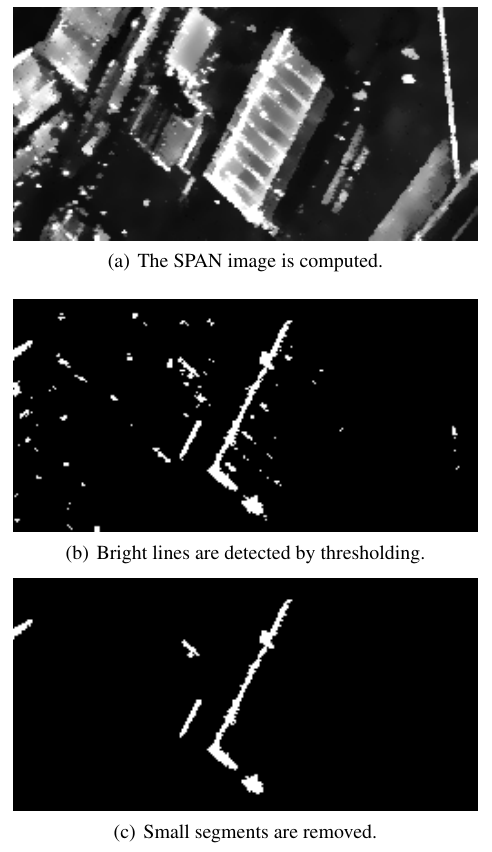
Figure 4: Extraction of bright lines corresponding to building cor- ners.